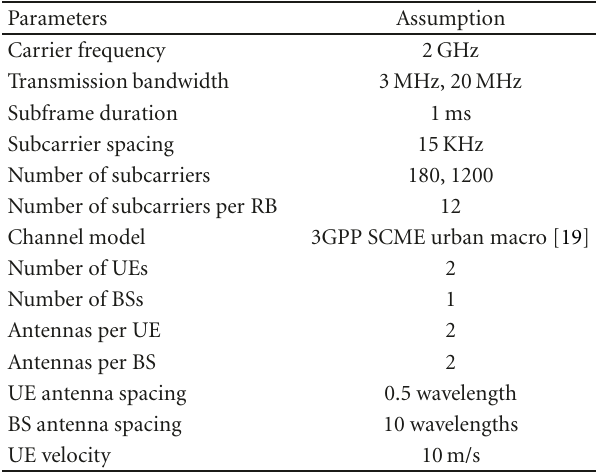
Table 1: Parameter assumptions for